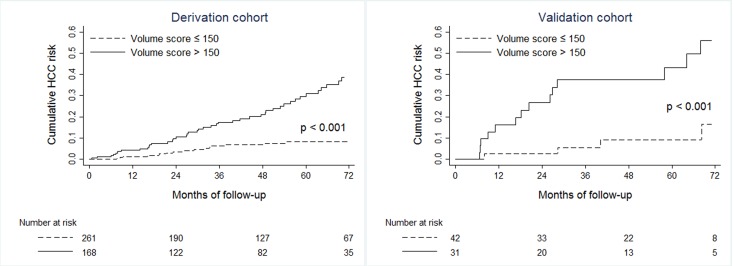
Stratification of HCC probability by nomogram-based liver volume score.Kaplan-Meier probabilities of HCC incidence were plotted according to the liver volume score cut-off of 150 in the derivation and validation cohort.